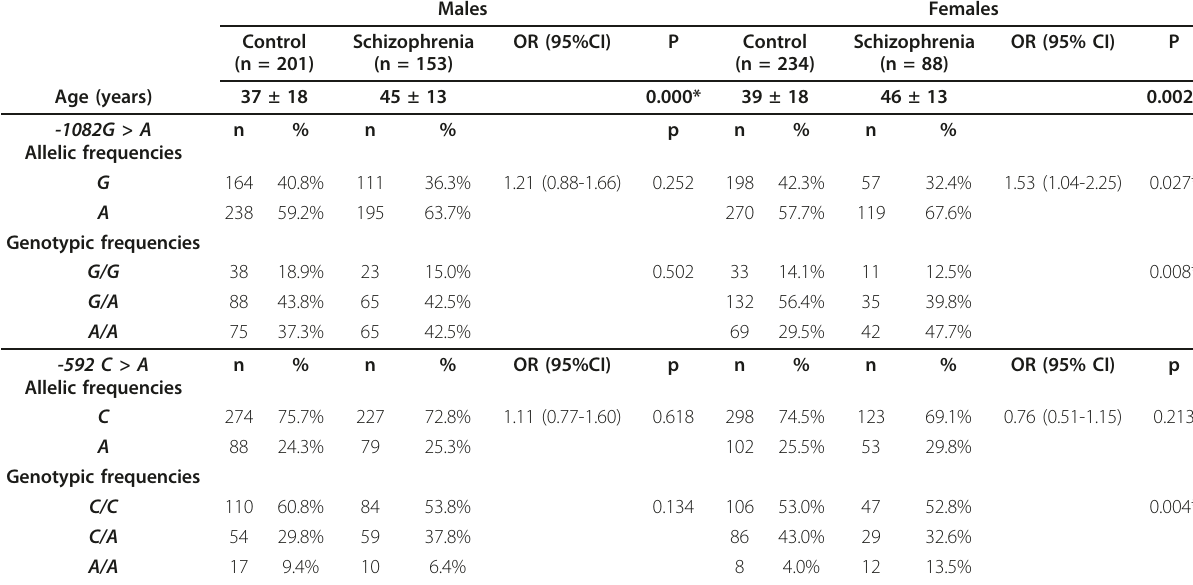
Table 1 Allelic and genotypic frequencies of - 1082G > A and -592C > A IL-10 gene promoter